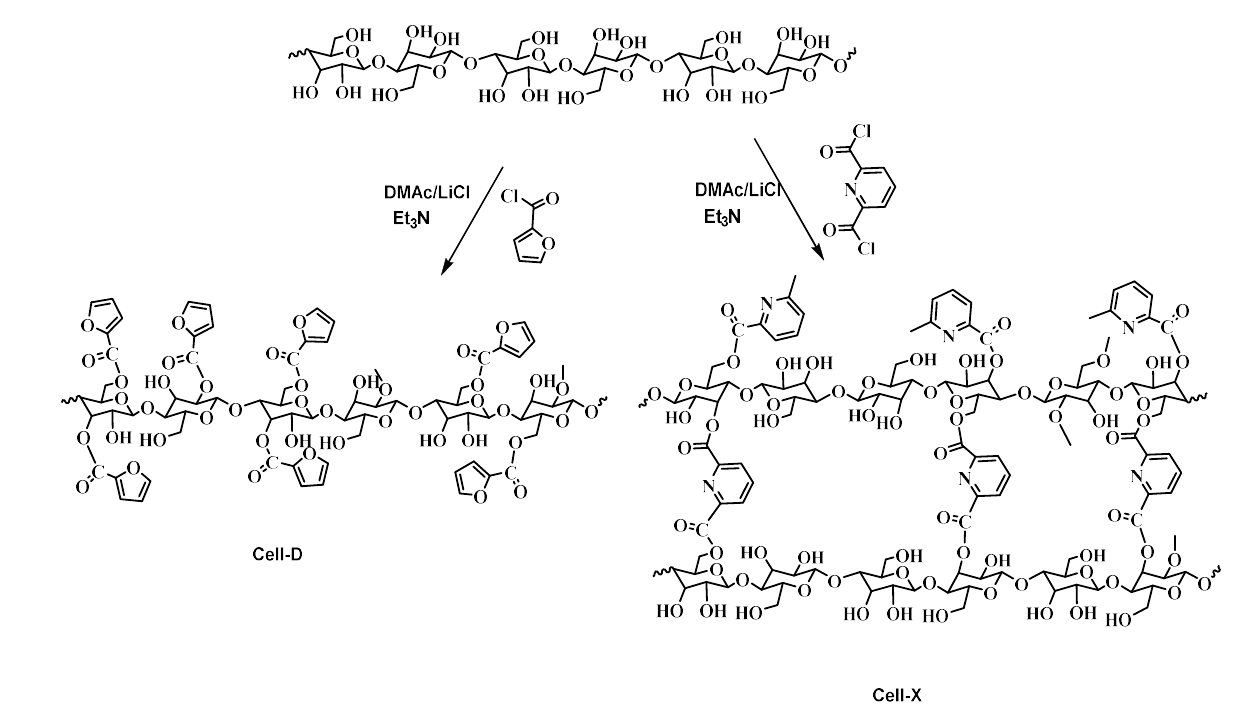
Figure 1. Preparation of Cell-D and Cell-X.